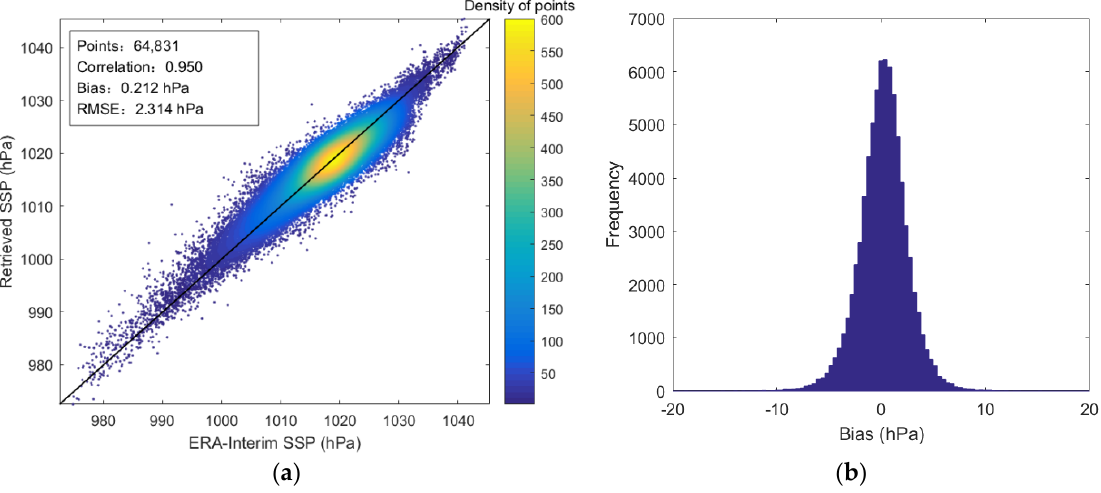
Figure 12. The SSP retrieval result and the distribution of retrieval bias from the theoretical channel combination: ( a ) The retrieval result; ( b ) The distribution of bias.